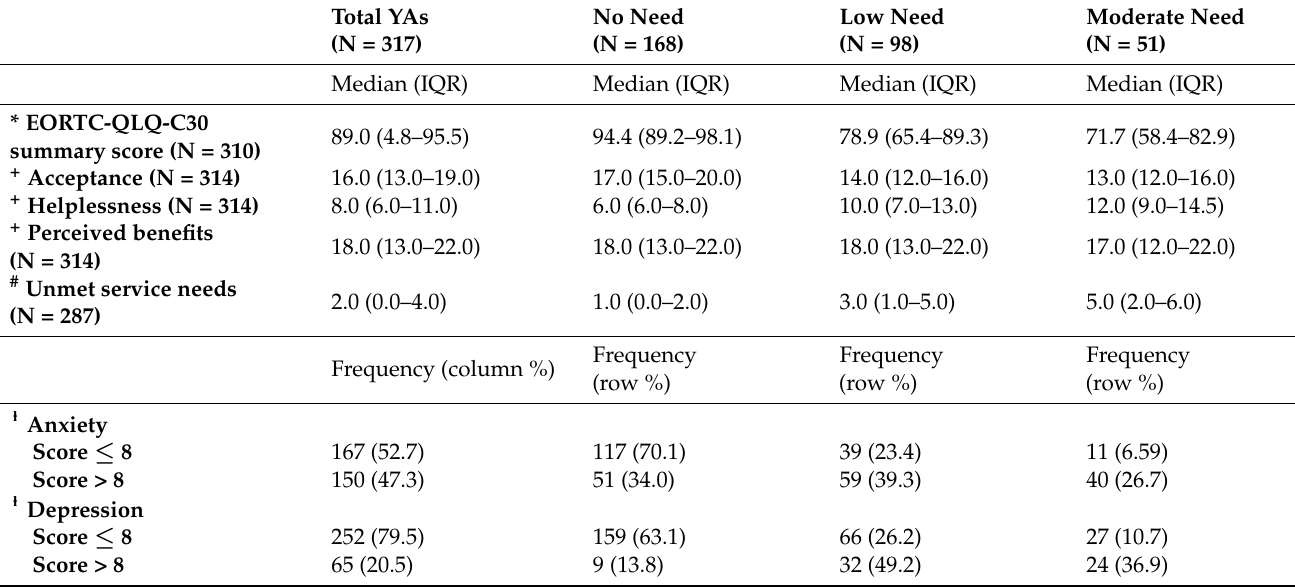
Table 4. Summary of psychosocial and service use outcomes in total sample and stratified by level of supportive care need.